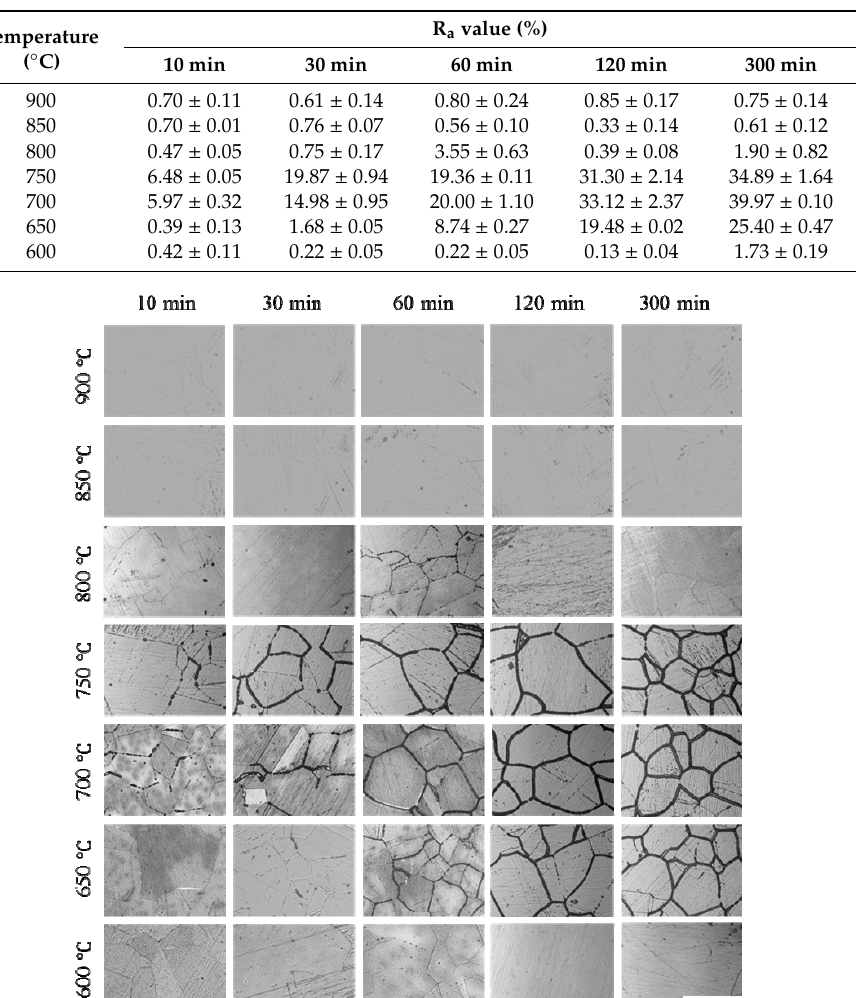
Table 2. R a values (%) of the Cr–Mn–Ni–N–Cu austenitic stainless steel samples under di ff erent heat treatment conditions after the DL-EPR test.